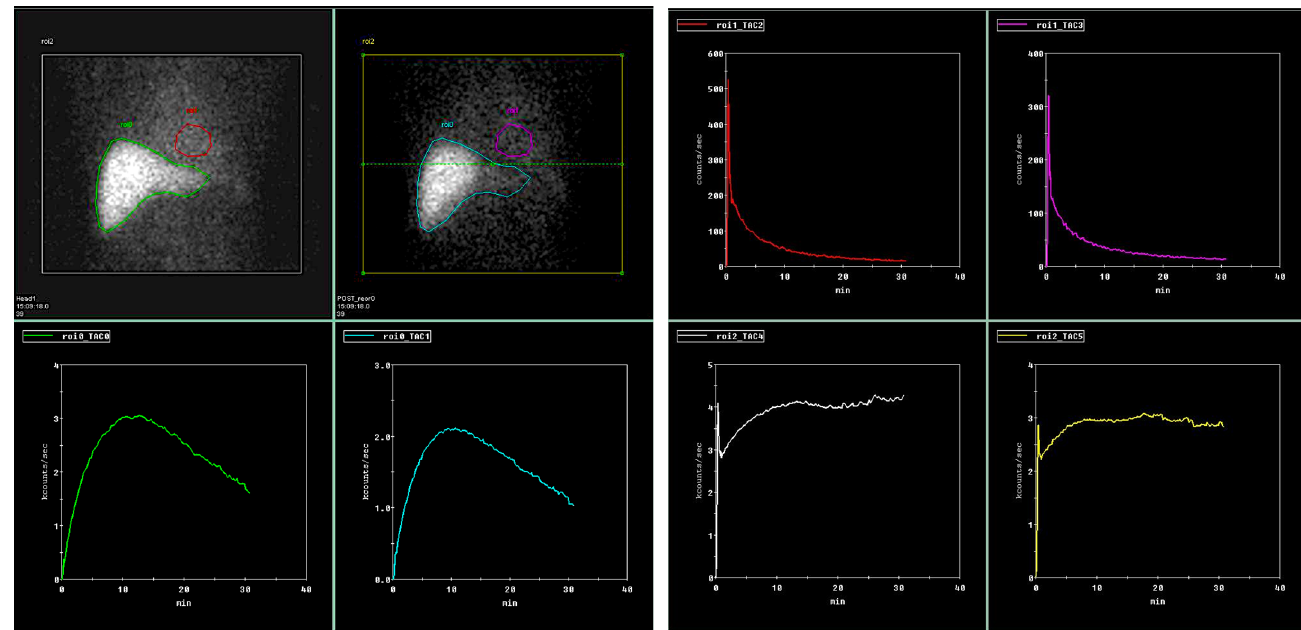
Figure 1. Liver clearance calculations from anterior and posterior dynamic liver scans. Green/electric blue curves representing liver area, red/pink curves representing heart area as an input function and white/yellow curves representing whole field of view. Calculations were made according to Ekman et al. [27].